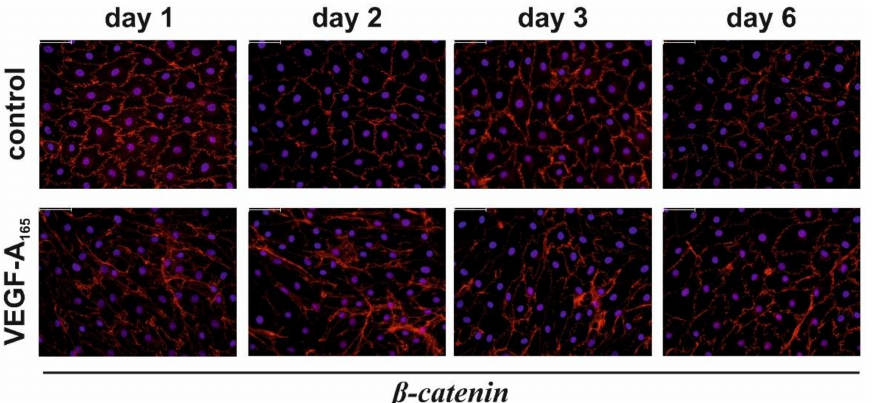
Figure 3. Plasma membrane localization of β -catenin was impaired by extended exposure of iBREC to VEGF-A 165 . Confluent cells were exposed to VEGF-A 165 and cells were fixated at indicated time points. Subcellular localization of β -catenin was visualized by immunofluorescence stainings with specific antibodies (red); nuclei were stained with DAPI (blue). In unchallenged cells, most of β - catenin was present at the plasma membrane, but exposure to VEGF-A 165 for one to three days resulted in its de-localization from the plasma membrane, less evident after extended exposure for six days. Scale bar 50 µ